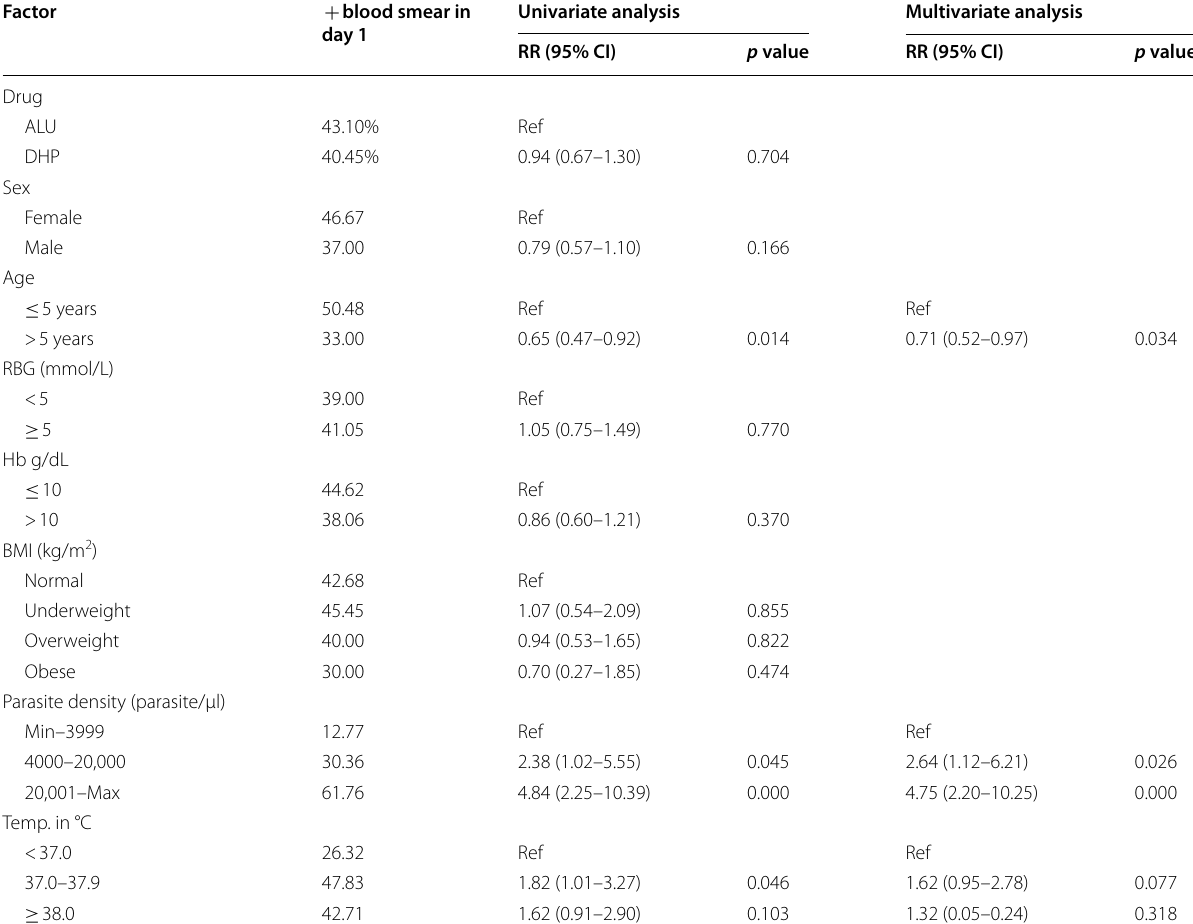
Table 3 Association between factors and a positive blood smear in day one